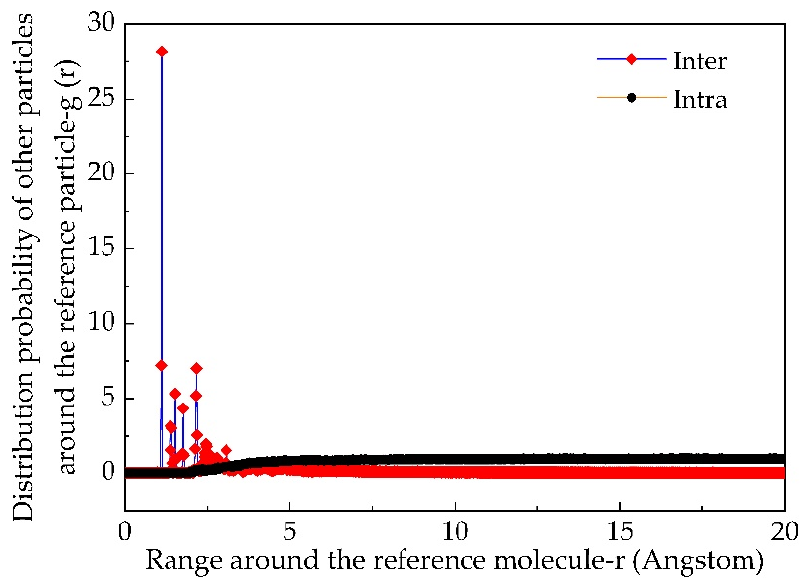
Figure 3. The dependence of atomic radial distribution as a function of the range